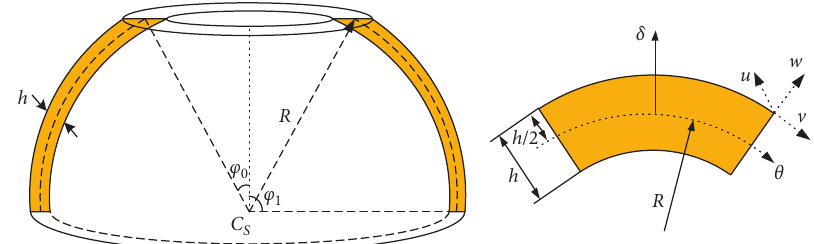
Figure 1: Geometry notations and coordinate system of the annular spherical